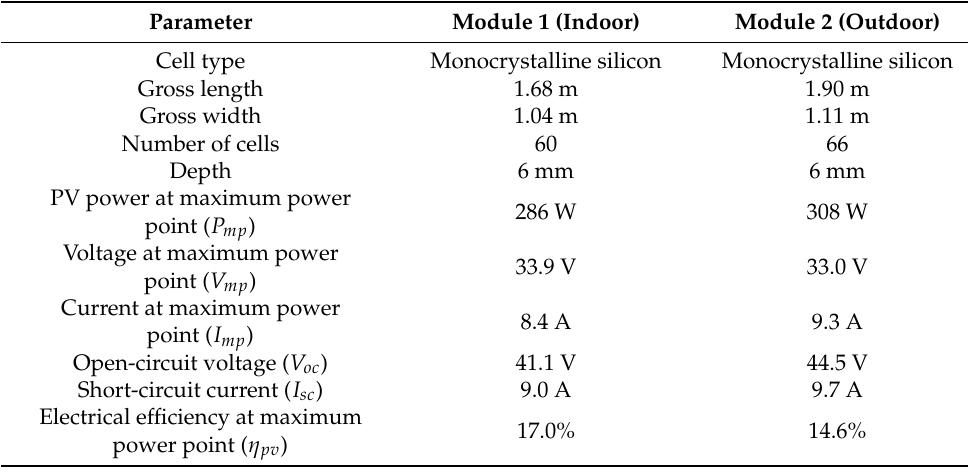
Figure 1. Air ‐ type BIPVT collector schematic: ( a ) Top view module ( left ) and perforated thermal plate ( right ) and ( b ) cross ‐ sectional profile showing airflow direction. Table 2. Key characteristics of modules 1 and 2 provided by the